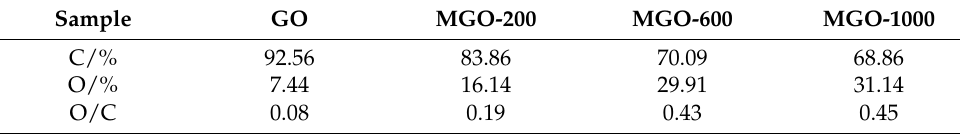
Table 1. The C and O element contents of GO and